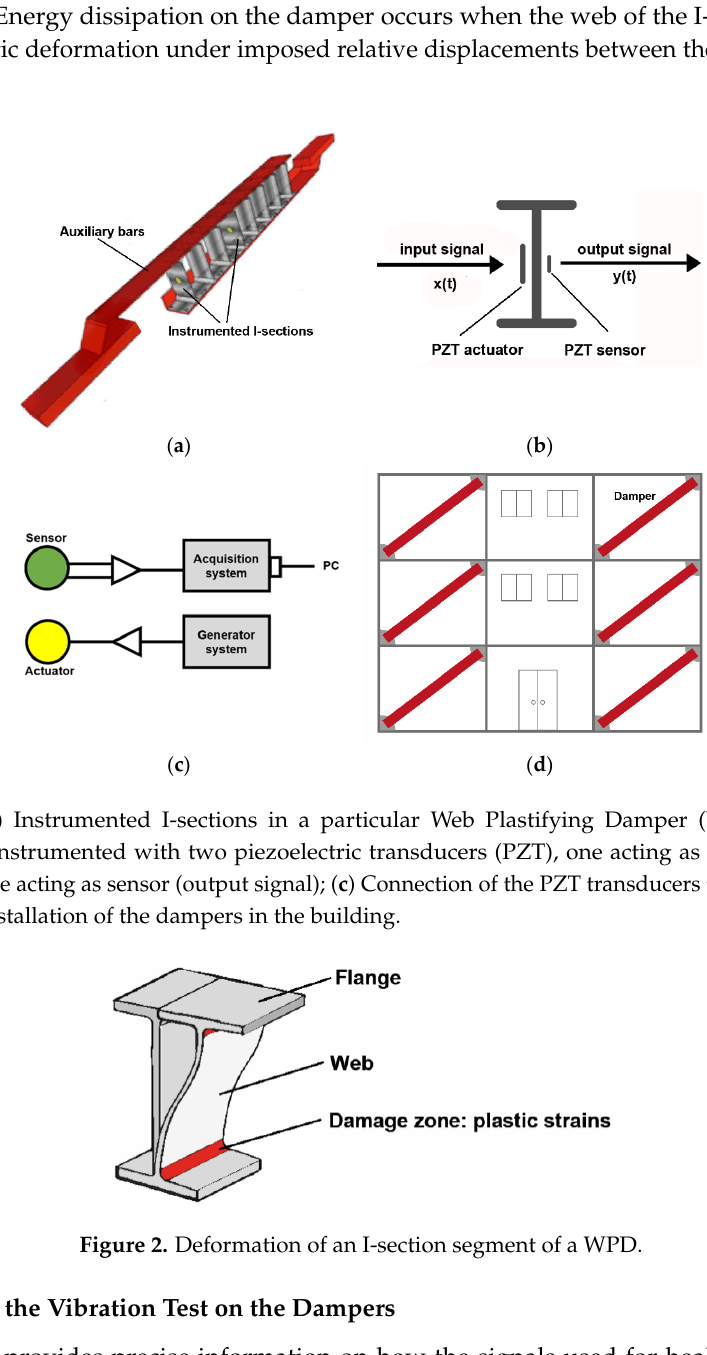
Figure 2. Deformation of an I ‐ section segment of a WPD.